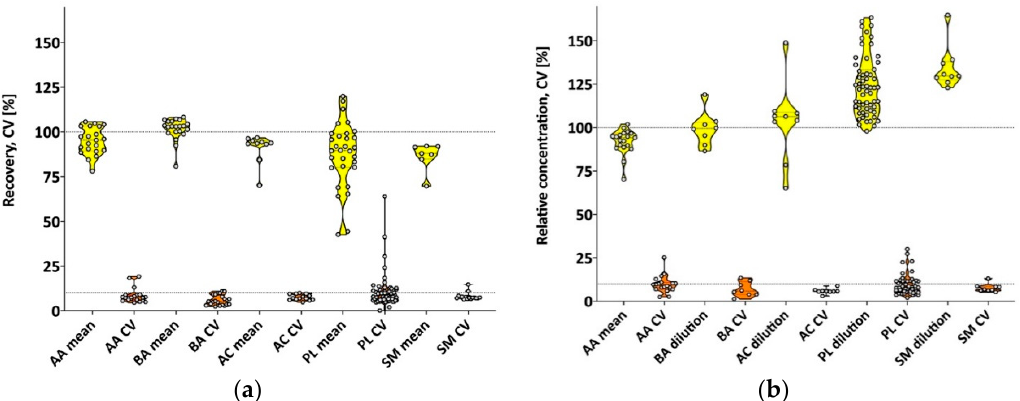
Figure 1. ( a ) Violin plots of mean milk metabolite recovery and coefficients of variation